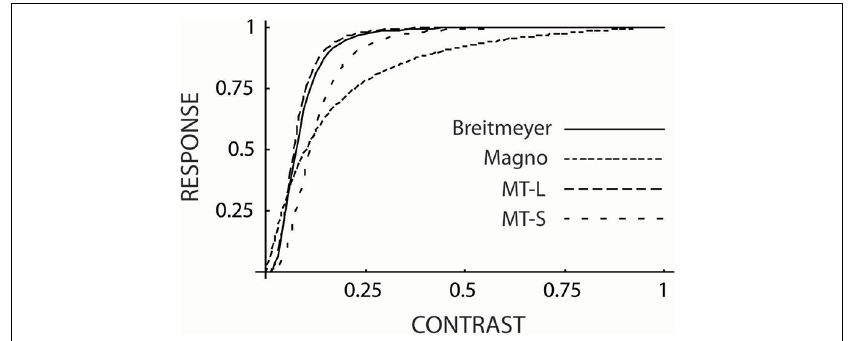
FIGURE 1 | The contrast-response curve from Breitmeyer (2014) (solid line) generated form Equation 1 which was by Breitmeyer attributed to magnocellular responses. Also shown are contrast-response curves for magnocellular cells (dotted line) and for cells in cortical Area MT of the dorsal stream for large (MT-L) and small stimuli (MT-S). These functions were generated from Equation 2 (see text). As can be seen, the curve of Breitmeyer is much closer to the functions for the MT cells than to the one for magnocellular cells and is well within the range of MT cell responses to large and small